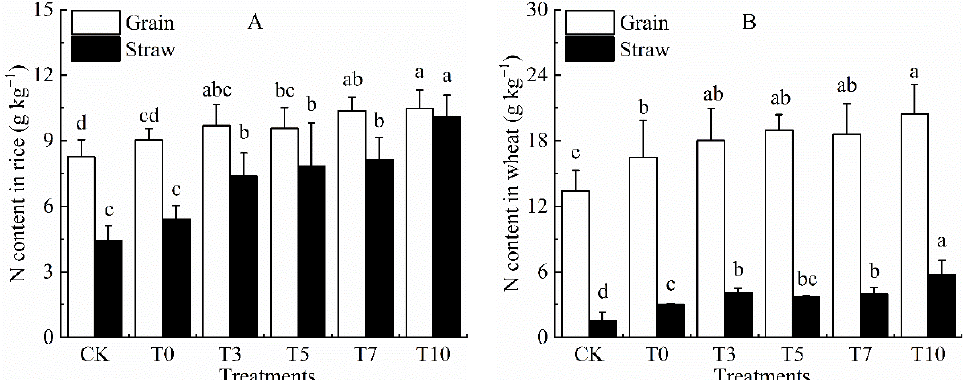
Figure 2. Effect of different fertilization treatments on nitrogen uptake in grains and straws of rice ( A ) and wheat ( B ). N-nitrogen. Columns with different small case letters show significant difference between different treatments at p < 0.05 by LSD’s multiple range test. Values are mean of four replicates and bars show standard deviation. CK, no nitrogen fertilizer applied; T0, 100% conventional urea (CU); T3, one-time basal application of slow-release urea (SRU) and CU mixture with 30% SRU; T5, one-time basal application of SRU and CU mixture with 50% SRU; T7, one-time basal application of SRU and CU mixture with 70% SRU; T10, one-time basal application of 100% SRU. The nitrogen contents of wheat grains and straws from treatment T0 were 16.49